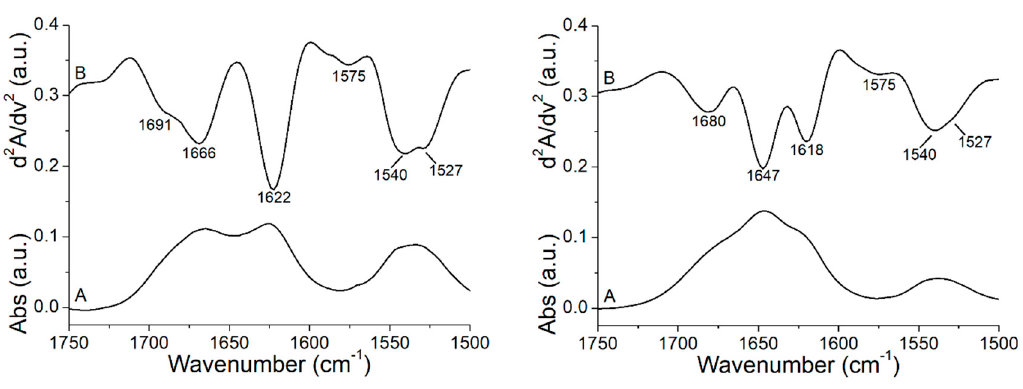
Figure 4. Original absorbance (A) and second derivative (B), FTIR spectra of the peptide +2 ( left ) and +5 ( right ) between 1750 and 1500 cm − 1 at RT.